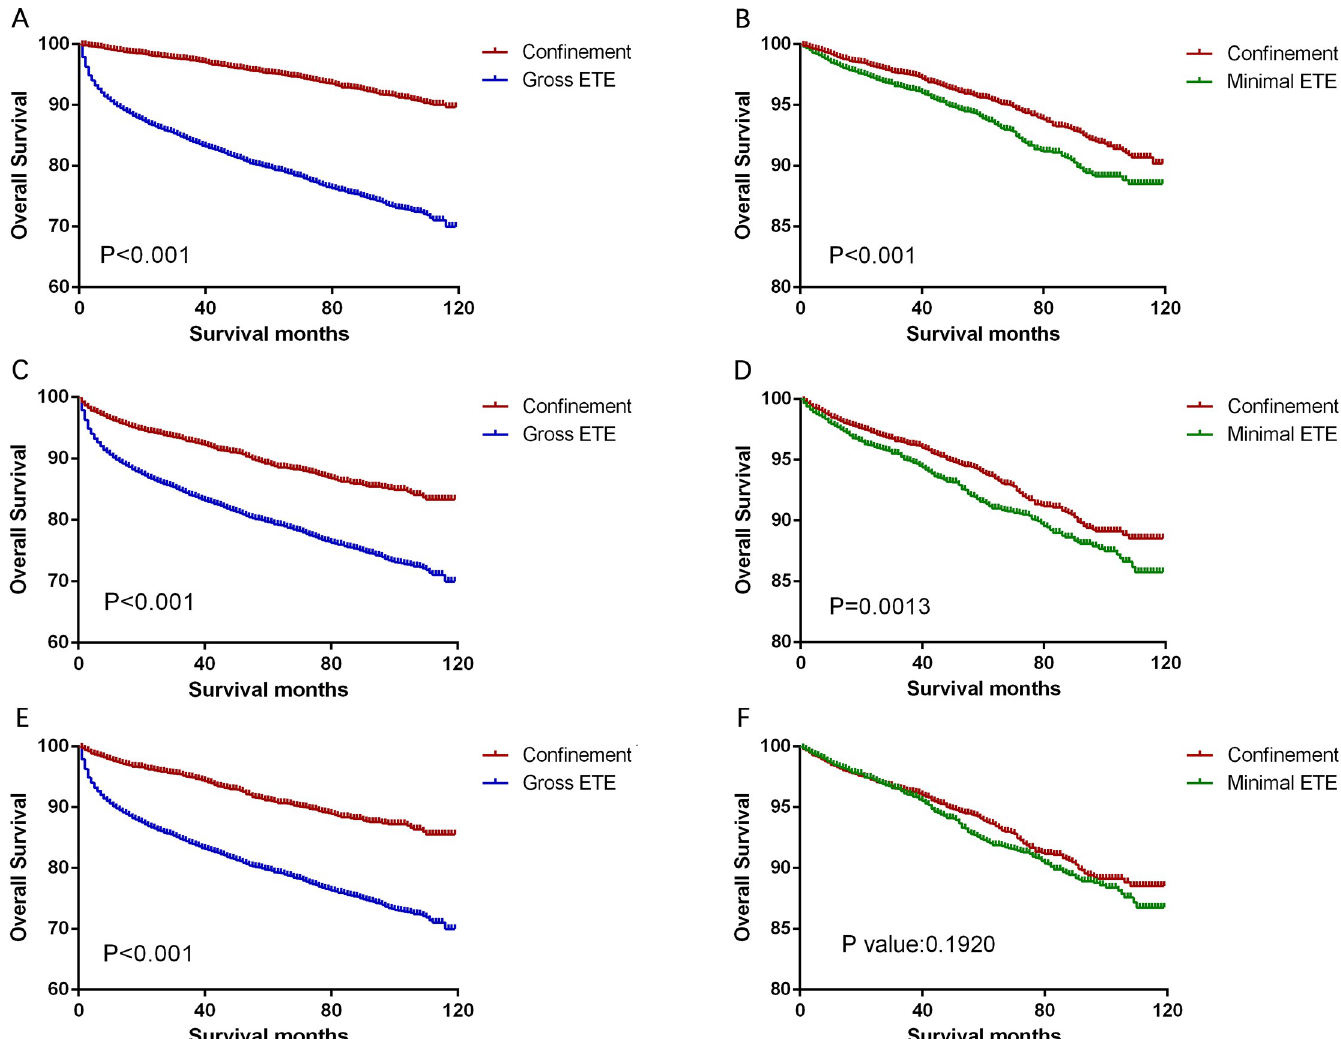
Fig 3. Kaplan-Meier curves for overall survival in the matched subtype pairs. Age, sex, and race matching was performed between the thyroid confinement and gross ETE groups (A) and between the thyroid confinement and minimal ETE groups (B). Age, sex, race, TNM stage, and multifocality matching was performed between the thyroid confinement and gross ETE groups (C) and between the thyroid confinement and minimal ETE groups (D). Age, sex, race, TNM stage, multifocality, surgery, and radiation treatment matching was performed between the thyroid confinement and gross ETE groups (E) and between the thyroid confinement and minimal ETE groups